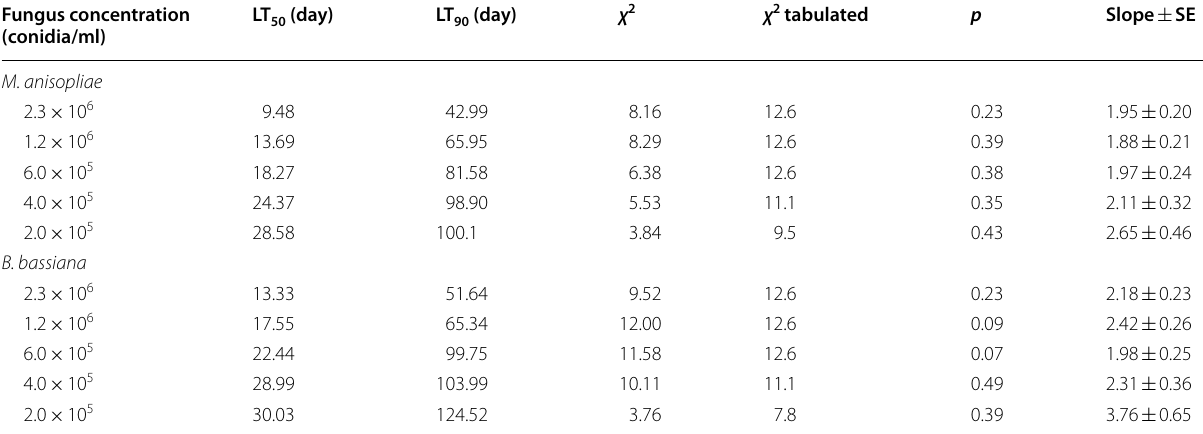
and LT (day)) for Bactrocera zonata fly treated with different fungal concentrations of Metarhizium 50 90